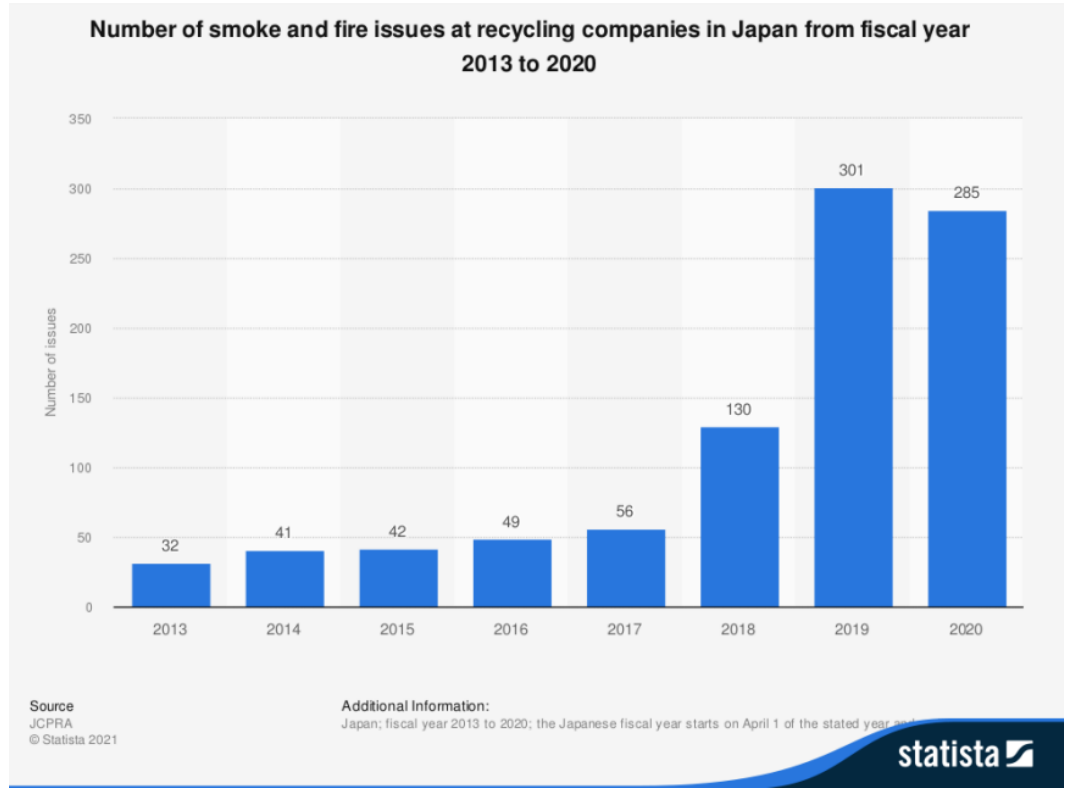
10 of 13 Figure 7. Trials with a magnesium fire (15 kg) inside a car. The cellulose flakes were able to control the flames. See text for details. As Figure 7 (left) shows, the flames were more than 3 m high, due to the intensifying effect of the burning Mg. The test setup was intended to mimic burning magnesium parts in a real-life scenario, e.g., from battery casings inside a car (compare [21]). In Figure 7 (right), one can see that the flames have vanished and that cellulose flakes are lying on the ground behind the car. For the next step, the firefighter can now apply a water spray to cool down the material. As Figure 7a,b show, the firefighter can attack the fire from a distance; if he were using sand or another heavy material, he would have to come closer to shovel them on, thus putting him at more risk.